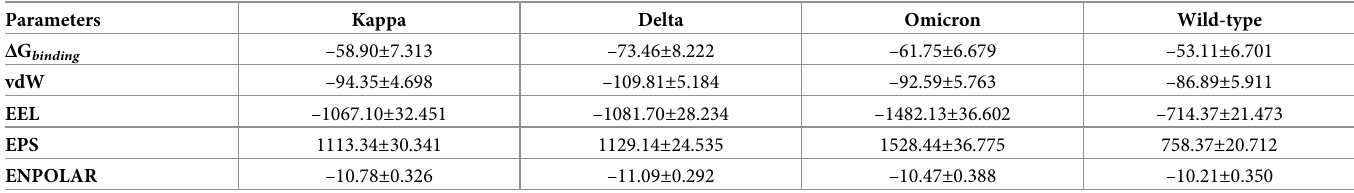
Note: The vdW and EEL represent van der Waals and the electrostatic contributions from MM, respectively. EPS stands for PB electrostatic contribution to the polar solvation free energy, while ENPOLAR is the nonpolar contribution to the solvation free energy. Δ G binding (kcal mol –1 ) is the final estimated binding free energy calculated from the terms